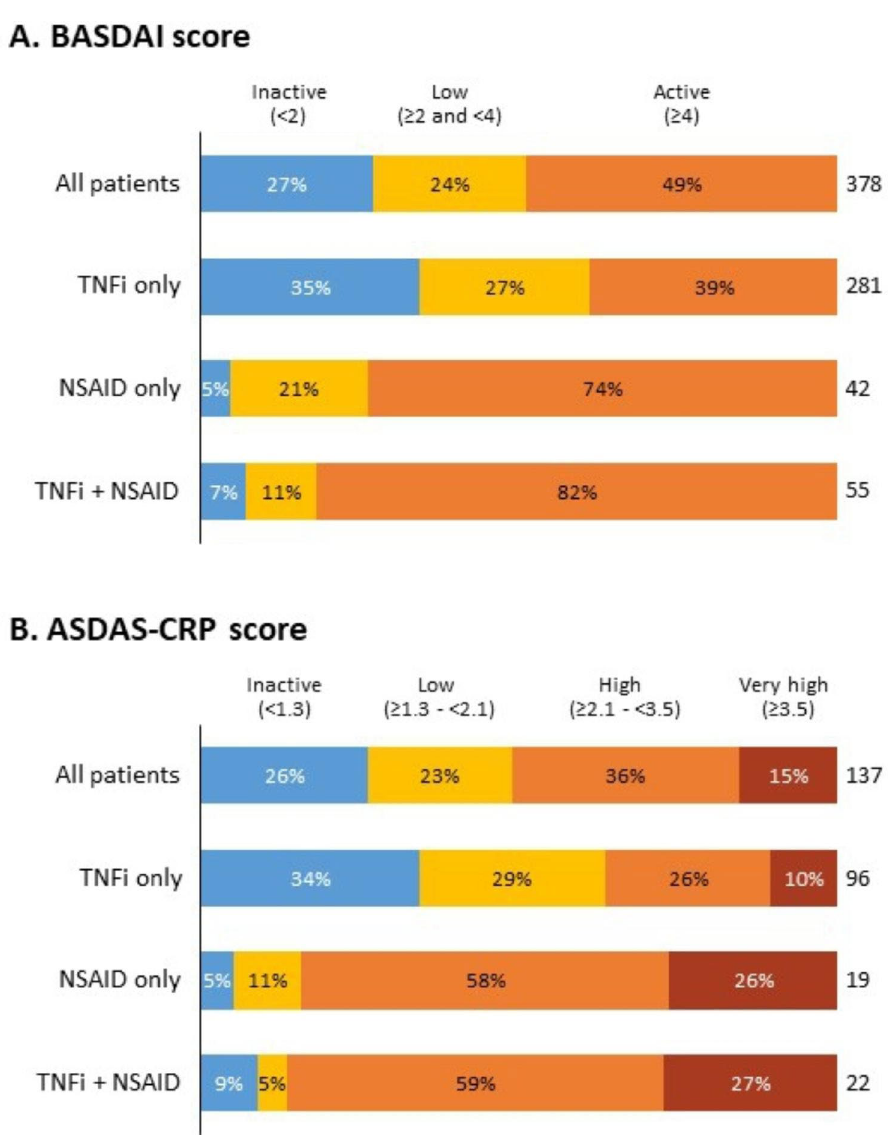
Fig. 1 Disease activity according to (A) BASDAI and (B) ASDAS-CRP, as the number and percentage of patients defined as inactive (blue), low disease activity (yellow), active or high activity (orange), and very high activity [ASDAS-CRP only] (dark